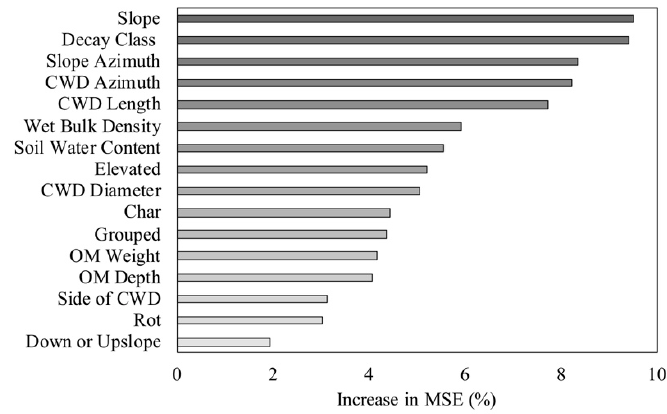
Figure 6. Importance ranking for the influence of coarse woody debris (CWD) attributes and site characteristics on woody plant density for stems <5 cm dbh in a Pinus palustris woodland after catastrophic disturbance. The increase in mean square error (MSE) indicates the increase in model error when the given variable was randomly permuted.